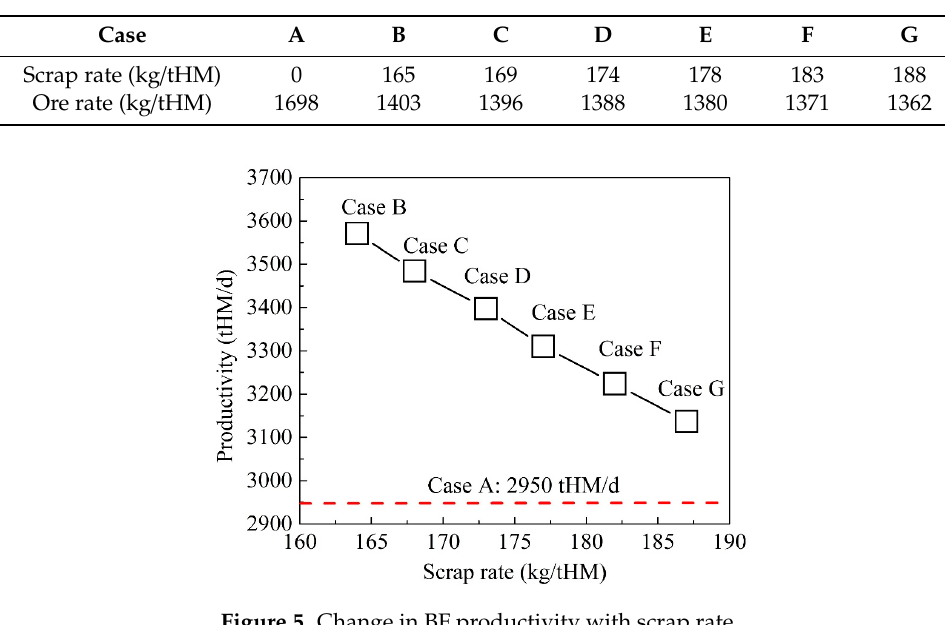
Table 8. Scrap rate in simulated cases.